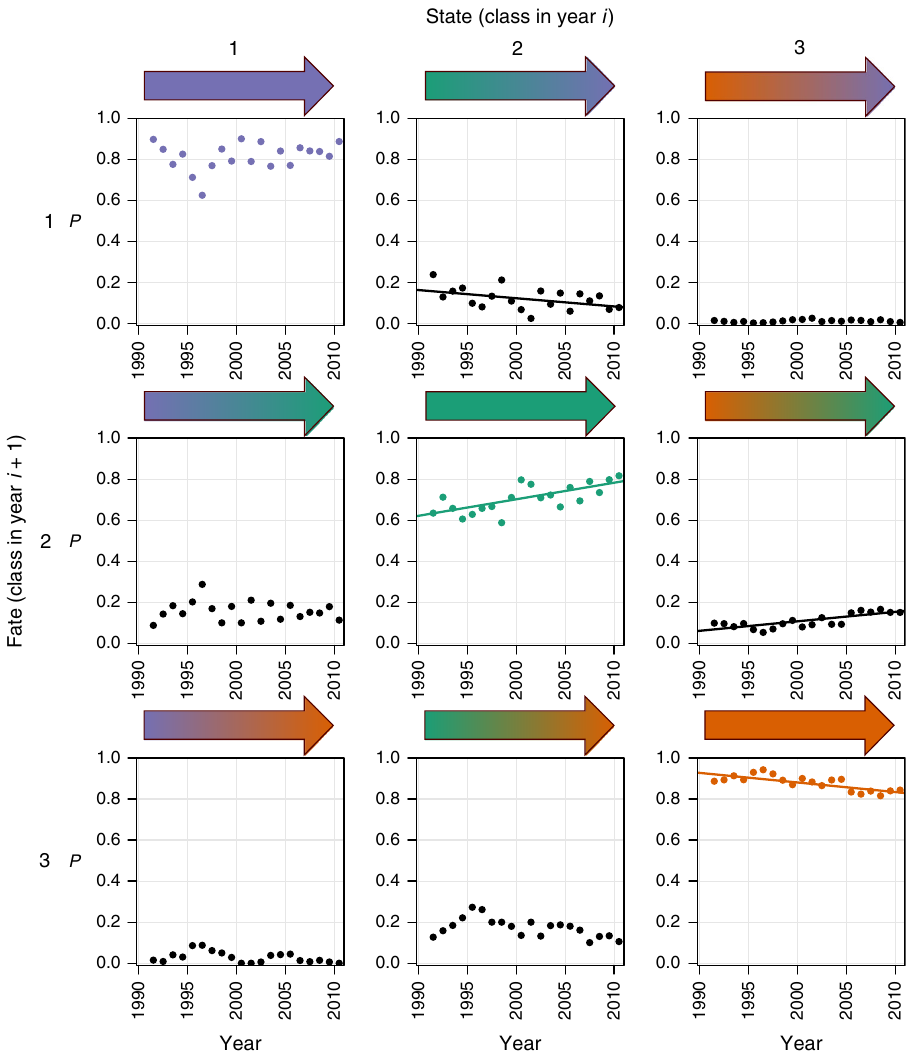
Fig. 2 Annual transition probabilities between the three macroinvertebrate community classes (1991 – 2011) across England and Wales, based on the Markov chain. Each panel shows the probability ( P ) of a community in one of the three states in 1 year either staying in the same state or switching to one of the other two in the following year (its fate). Colours follow Fig. 1, with fi ll colours of the arrows indicating the transitions between the different states. The three panels forming the leading diagonal represent the probability of communities staying in the same state between years ( = the persistence). Fitted linear regression lines are shown where the slope coef fi cient is signi fi cant at P ≤ 0.05 (see Supplementary Table 4 for regression results). Source data are provided as a Source Data fi